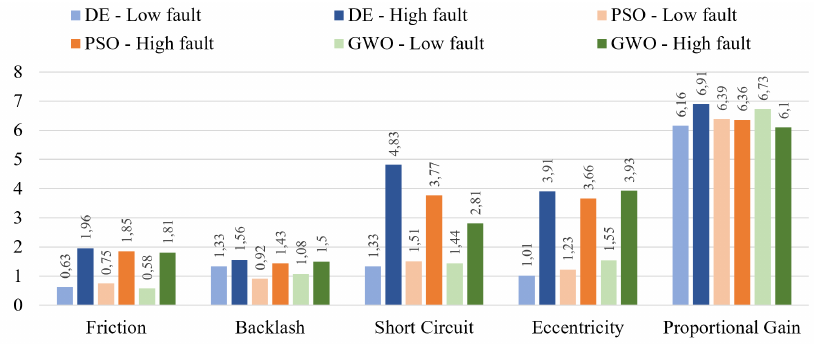
Figure 8. Comparison between different algorithms: computational cost [s]. For each failure mode and for each algorithm, the failure magnitudes are selected as follows: high magnitude ( k i = 0.75) and low one ( k i =